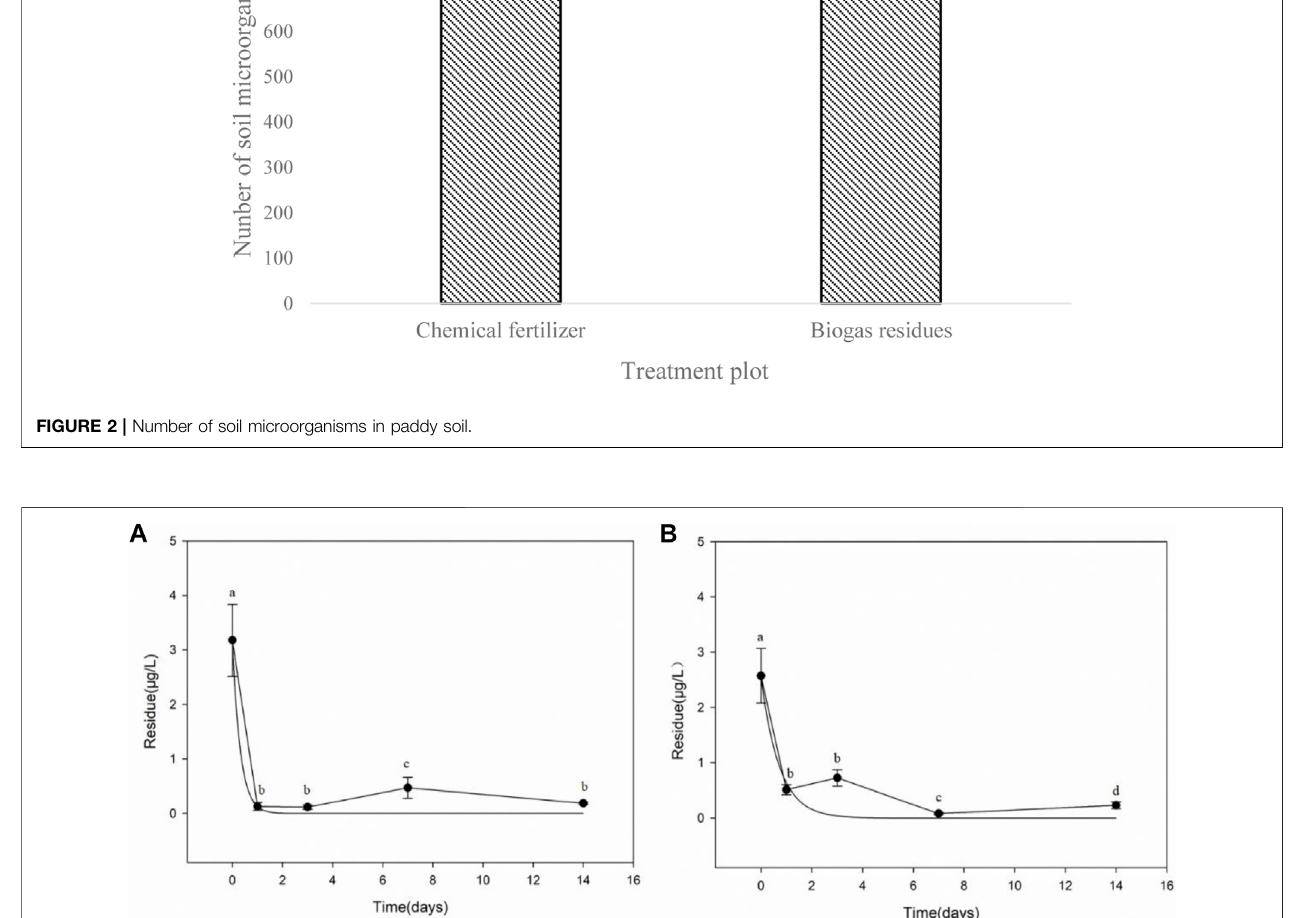
Frontiers in Environmental Science |